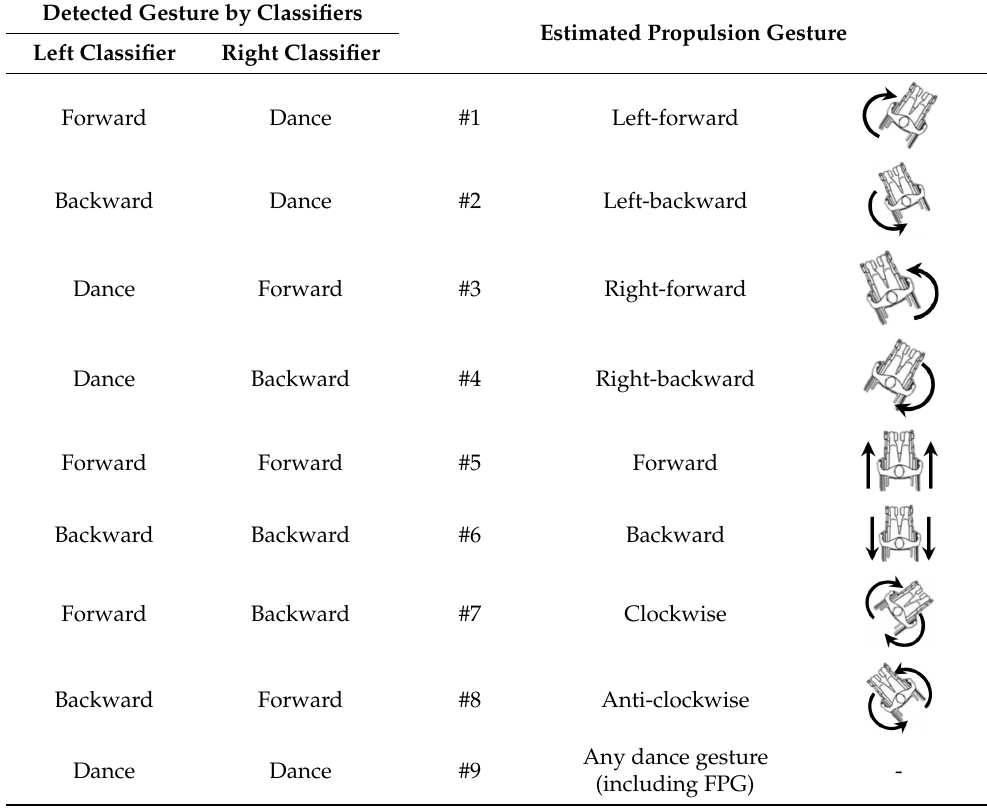
Table 7. Propulsion gesture estimation from classifier predictions.